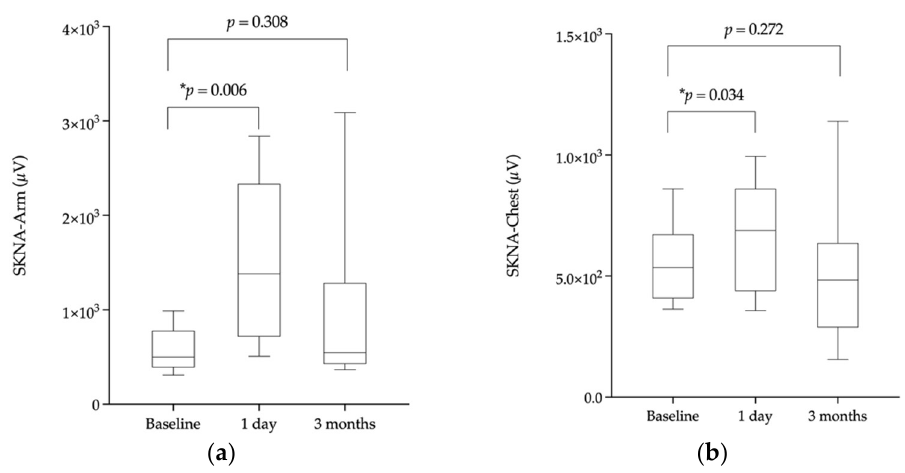
Figure 2. The box plot depicting skin nerve activity (SKNA) at baseline, 1 day after ablation, and 3 months after ablation. A box contains from the first quartile to the third quartile, and the segment inside shows the median. The whiskers above and below the box show the 90% percentile and 10% of percentile of the distribution, respectively. The asterisk represents p that is less than 0.05. ( a ) The change of SKNA-Arm over times; ( b ) the change of SKNA-Chest over times.